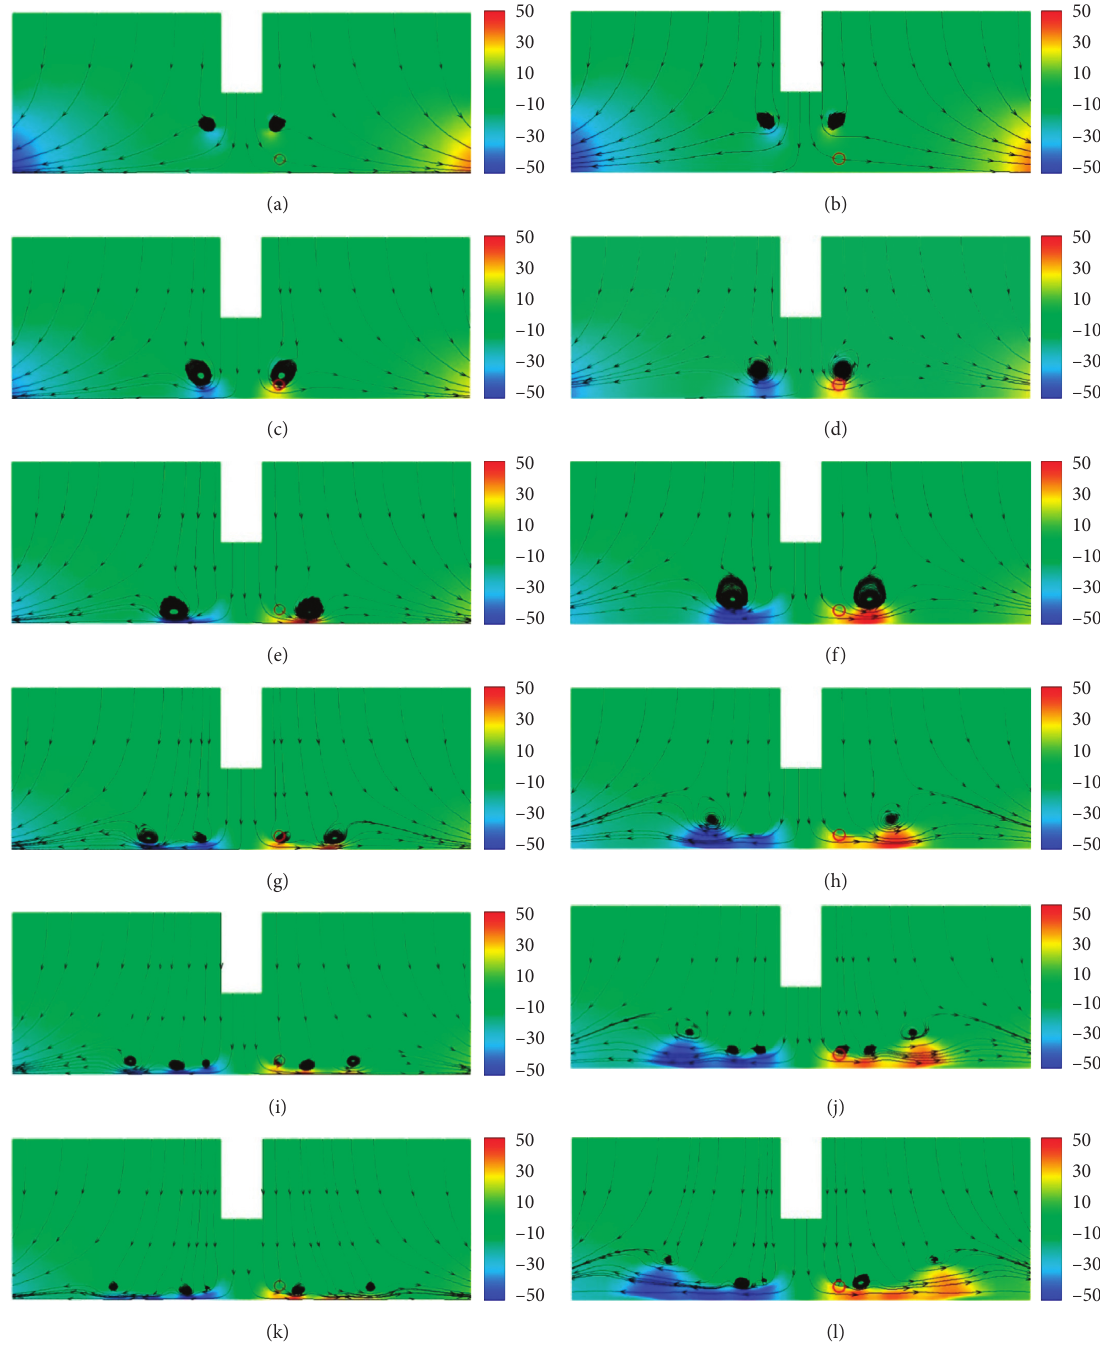
Figure 8: Streamlines and contour of wind speed in the flat and gorge terrains at different typical time. (a) Flat terrain, t � 50s. (b) Gorge terrain, t � 50 s. (c) Flat terrain, t � 100s. (d) Gorge terrain, t � 100 s. (e) Flat terrain, t � 150s. (f) Gorge terrain, t � 150s. (g) Flat